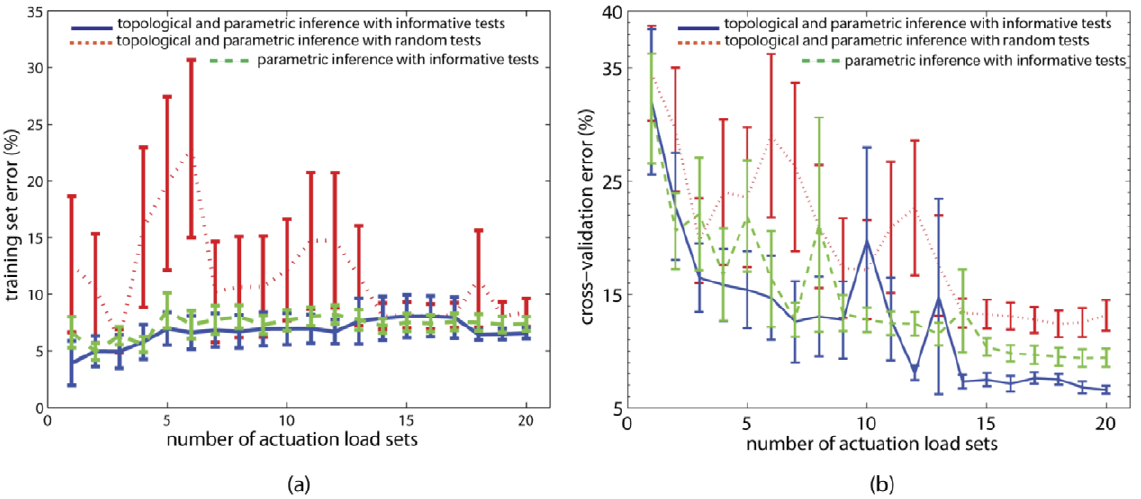
Figure 6. Topology matters and so does informative data generated from the inference process. Errors incurred during the inference of the finger extensor mechanism. (a) Training set errors. (b) Cross validation errors. Progression of the error values are depicted as the number of data sets are introduced for model evolution. Error values are depicted for five executions for the topologic and parametric inference using informative tests. Bars represent standard errors. Solid lines correspond to the mean error when informative data is employed in topological and parametric inference of the target. Dotted lines show mean errors when sequential random data sets are used (error bars depicted for 20 executions). Dashed lines represent mean errors (error bars depicted for 20 executions) when only parametric evolution is performed using the basic topology where